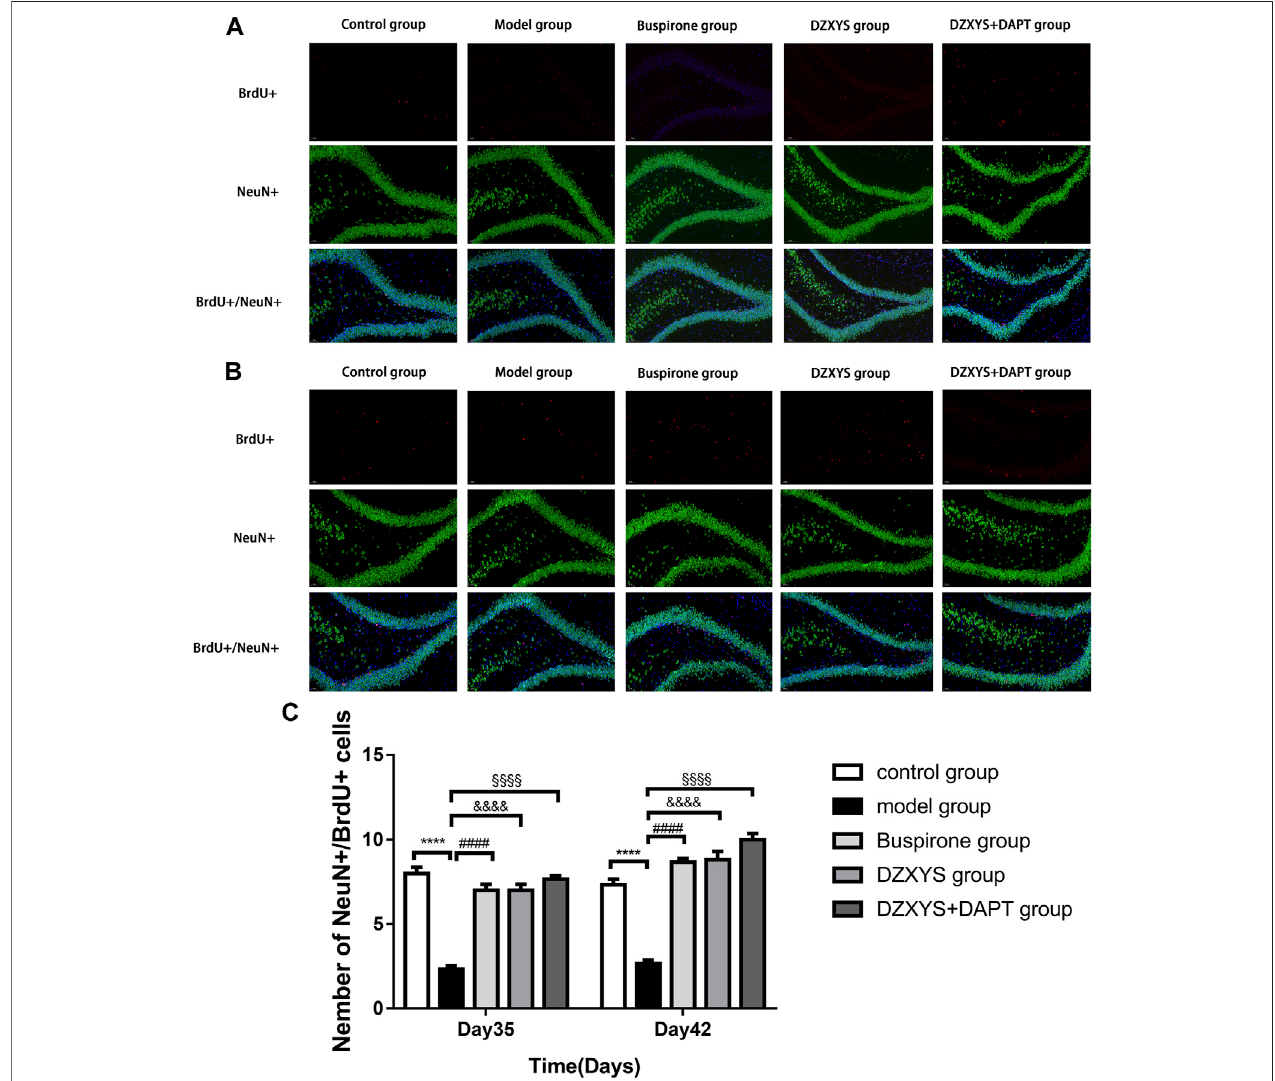
FIGURE 8 | The number of new neurons in the dentate gyrus of the hippocampus in each group. BrdU (red) labeled newly formed cells and NeuN (green)-labeled neurons.ThenucleiwerelabeledwithDAPI(blue) (A) Theregenerationofneuronswasobservedonthe35thday (B) Regenerationofneuronsonday42 (C) Thenumber of newborn neurons in the dentate gyrus of the hippocampus on the 35th and 42nd day. **** p < 0.0001, model group vs. control group; #### p < 0.0001, Buspirone group vs Model group; &&&& p < 0.0001, DZXYS group vs. model group; §§§§ p < 0.0001, DZXYS + DAPT group vs model group.